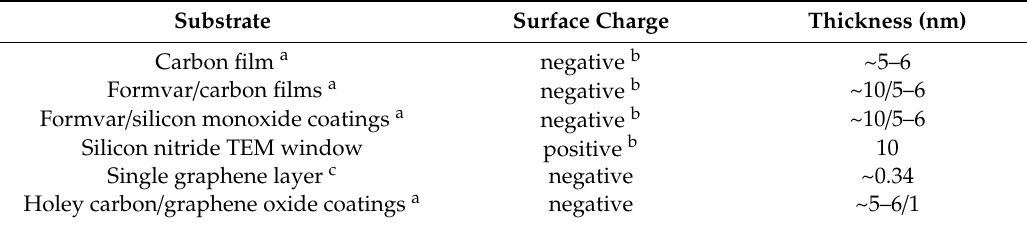
Table 1. Substrate and supporting coatings used in the study. Substrate Surface Charge Thickness